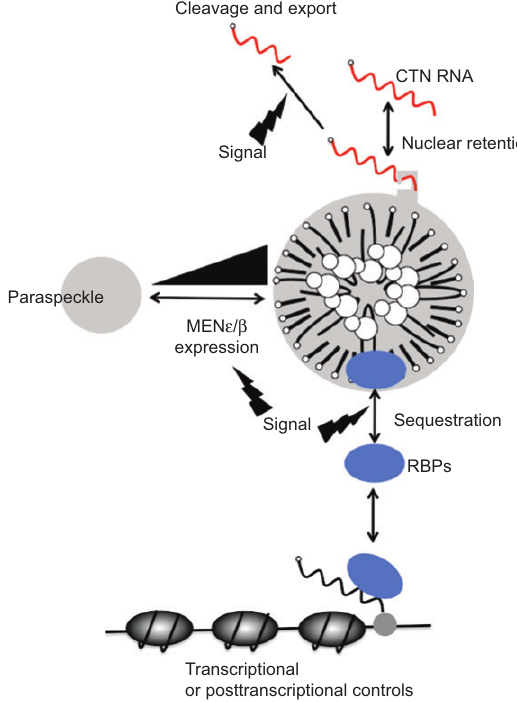
Figure 3 Model of paraspeckle functions. The paraspeckle size is dynamically altered depending on the expres- sion levels of MEN ε / β ncRNAs (fi lled triangle), which are controlled by certain signals. Above: Paraspeckle serves as the site of nuclear retention of a specifi c mRNA (e.g., CTN RNA) that is cleaved and exported to the cytoplasm upon exposure to certain signals. Below: Paraspeckle modulates the nucleoplasmic pool of RNA-binding pro- teins (RBPs), which play regulatory functions in the transcriptional and/or post-transcriptional regulation of the target genes occurring away from the